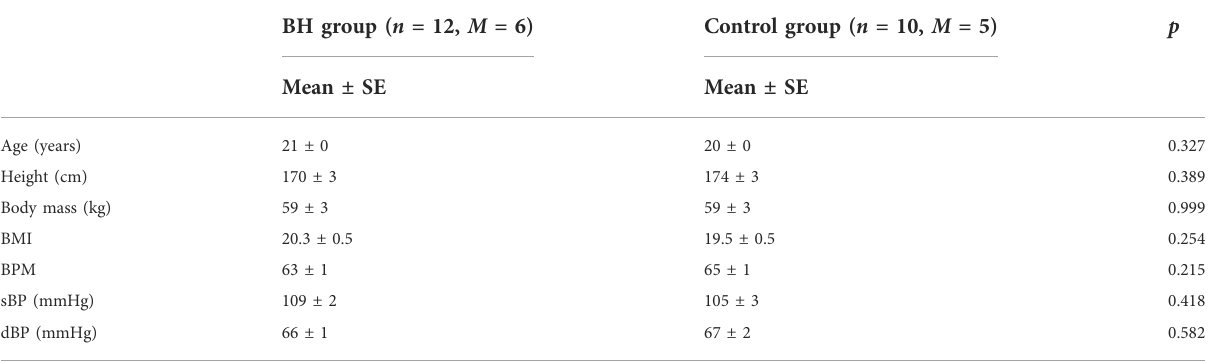
TABLE 1 Anthropometric characteristics of participants.